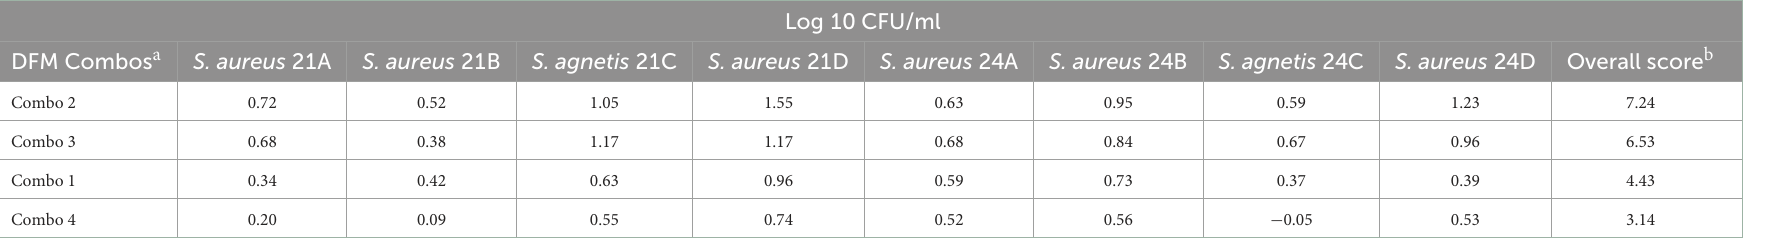
TABLE 5 S. agnetis and S. aureus reduction (log 10 CFU/ml) by DFM combos co-cultivated 24h on nutrient broth. DFM Combos